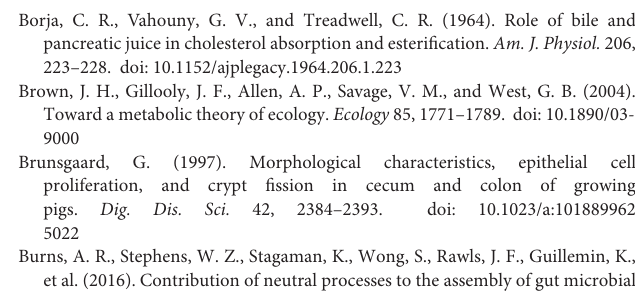
Supplementary Table 1 | Ingredient composition, nutrient, and energy content of the diet. Supplementary Table 2 | Nutrient and energy content of the